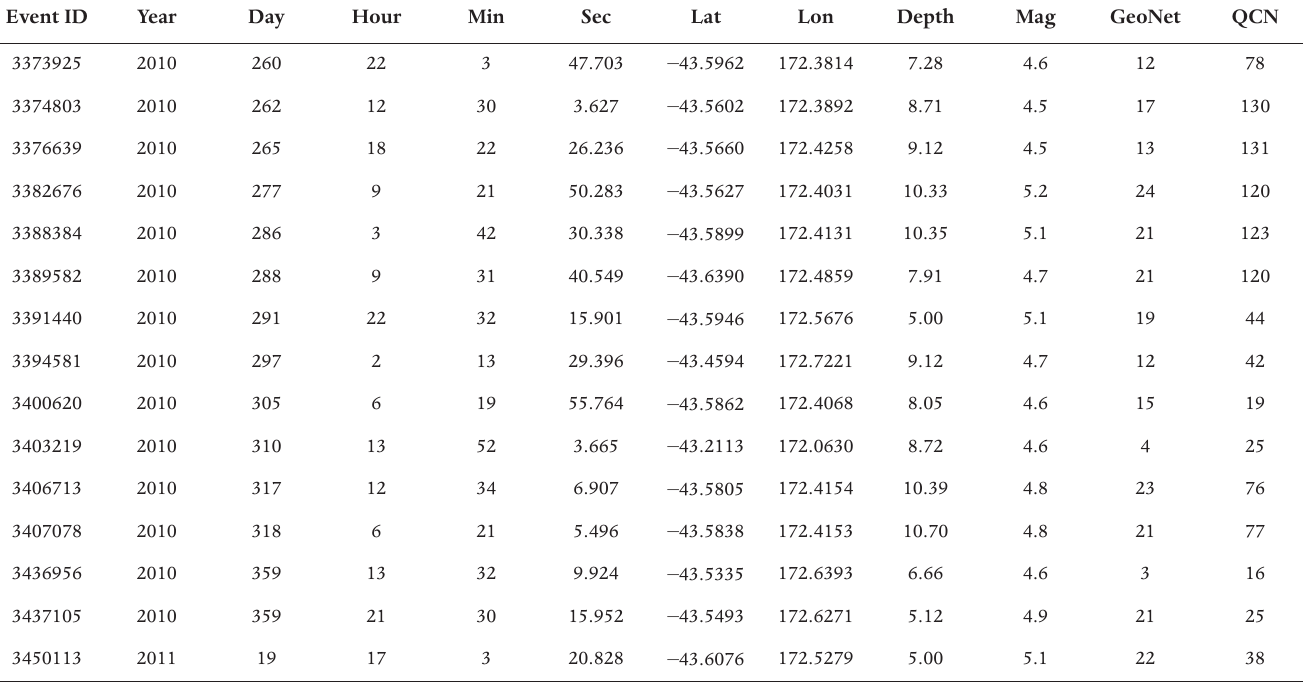
Table 1. M ≥ 4.5 Earthquakes: September 15, 2010, to January 31,